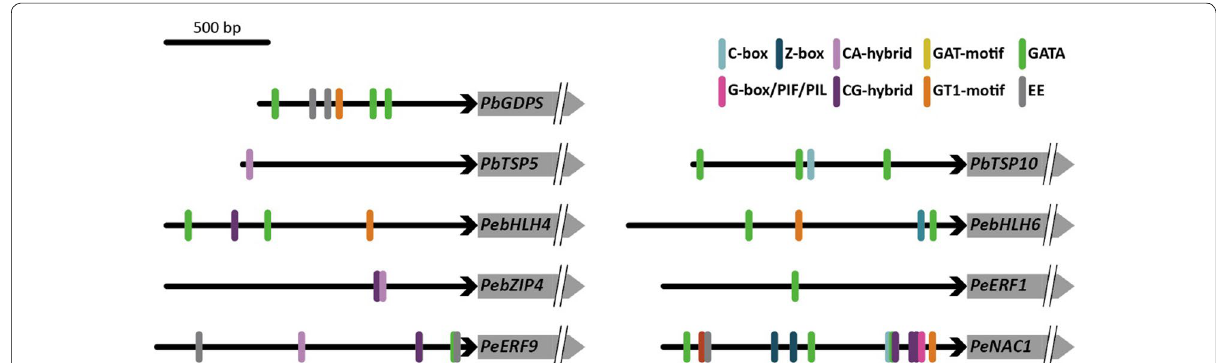
Fig. 5 Light‑ and circadian‑responsive elements on the upstream regulatory fragments of three structural genes and six transcription factors for floral monoterpene biosynthesis in P. bellina . The distinct cis ‑elements on each fragments were represented by their location predicted by PlantPAN (Chow et al. 2015). The gene length was not shown in proportion to actual length. Scale bar of upstream regulatory fragments